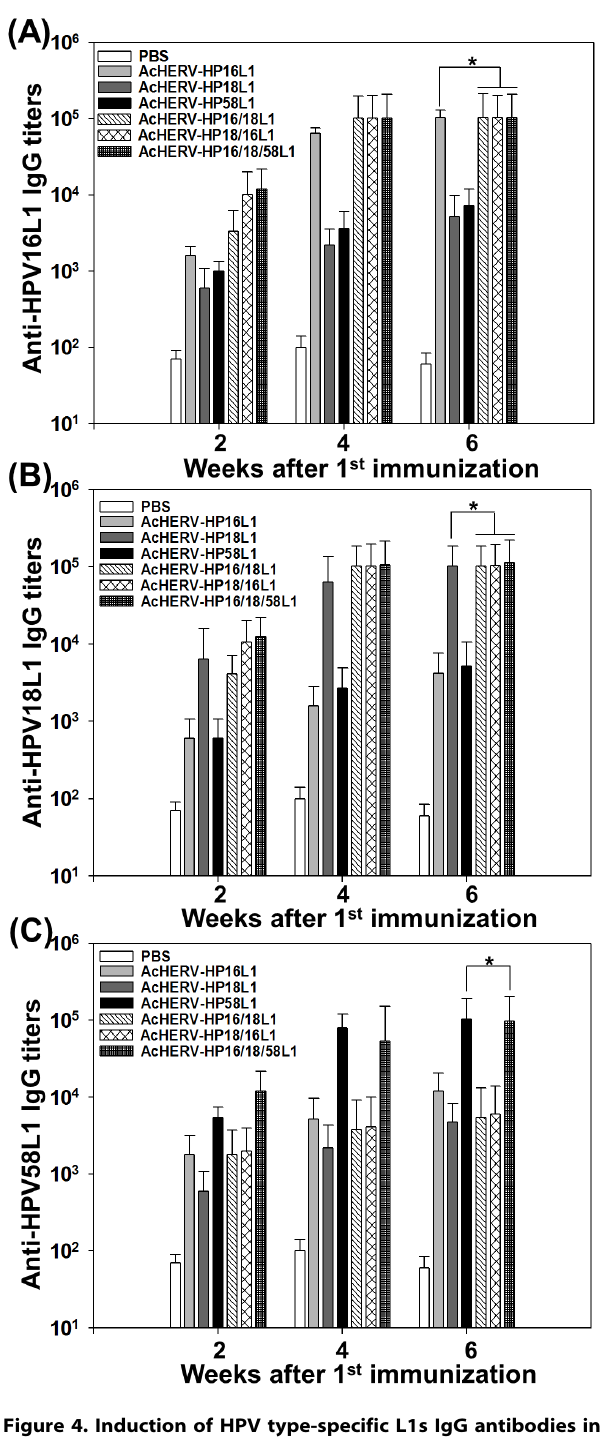
Figure 4. Induction of HPV type-specific L1s IgG antibodies in mouse serum. BALB/c mice were intramuscularly injected with PBS or 1 6 10 7 PFU of AcHERV-based nanovaccines. Antigen specific IgG antibodiy titers against HPV 16L1 (A), HPV 18L1 (B), or HPV 58L1 (C) in murine sera were determined by ELISA. * p , 0.05 (ANOVA and Student-Newman-Keuls test): Bivalent and trivalent groups were compared with each monovalent group.